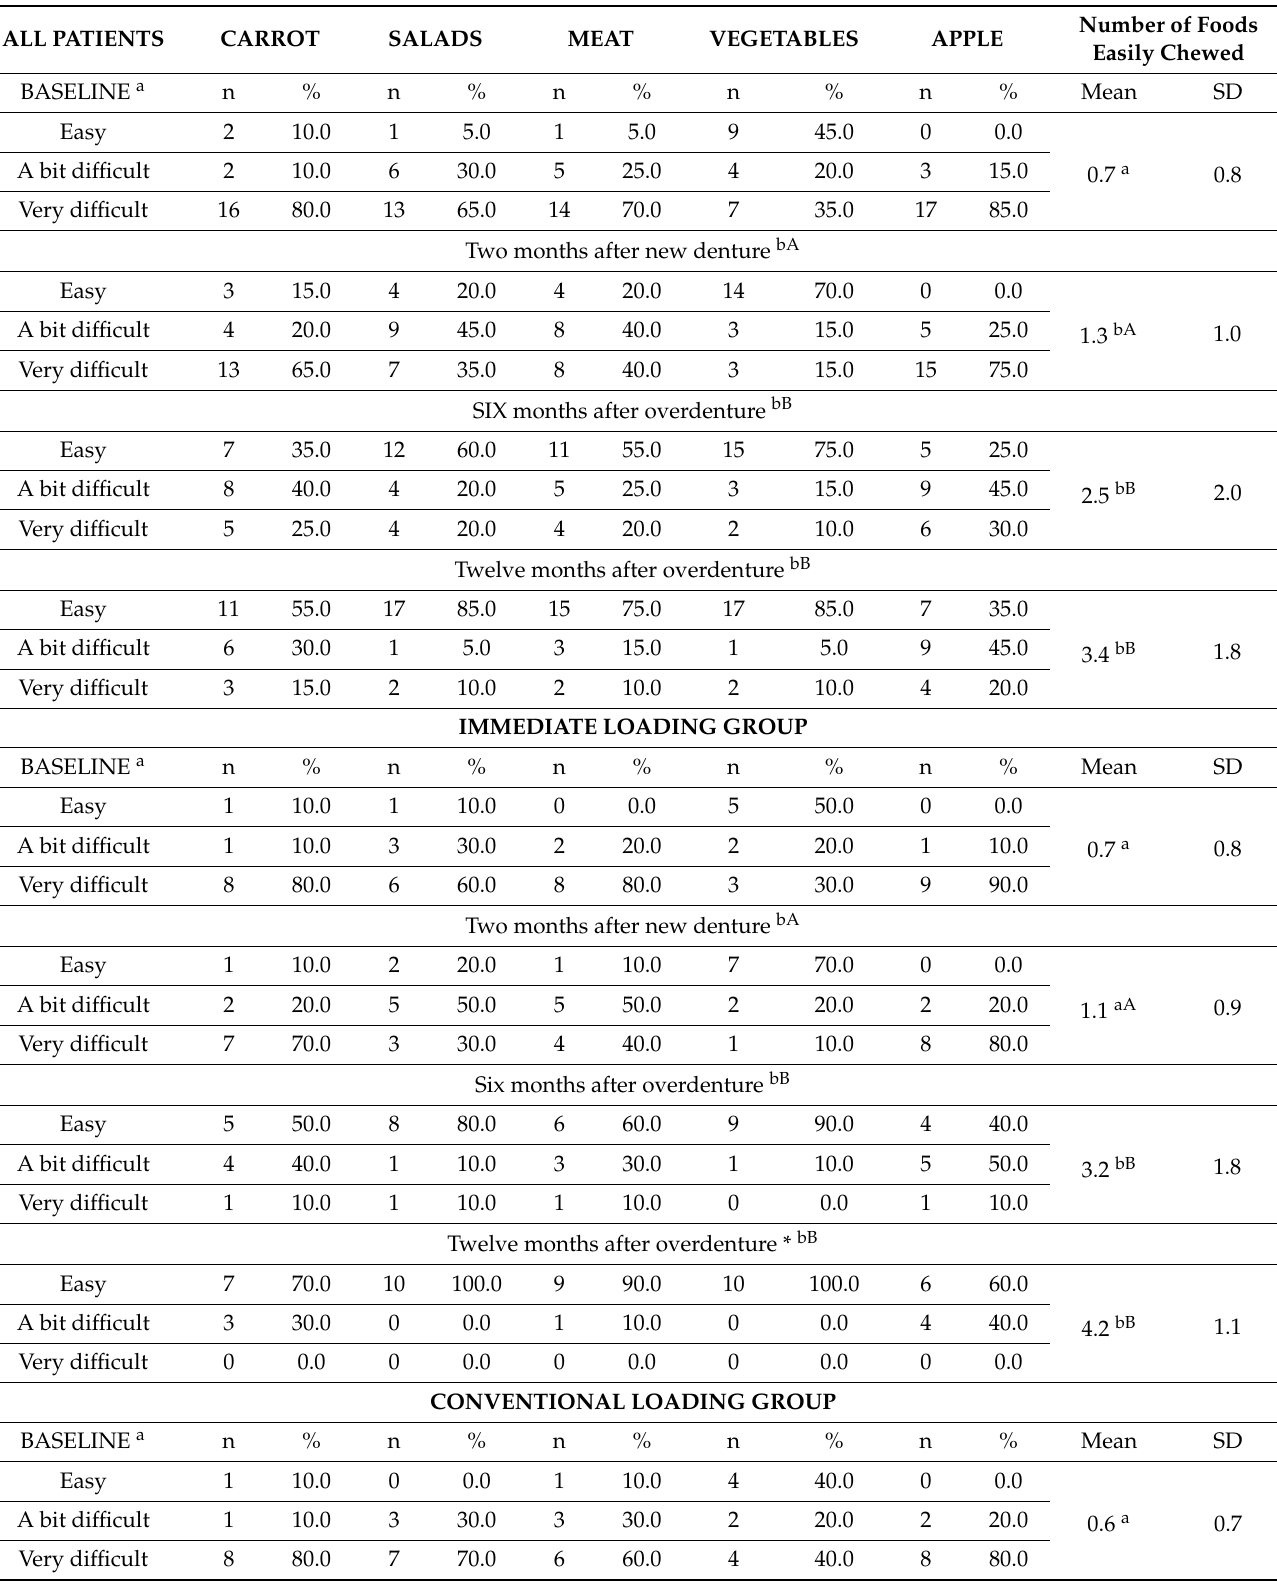
Table 6. Changes in chewing ability according to Leake Index after prosthetic treatments ( n = 20). ALL